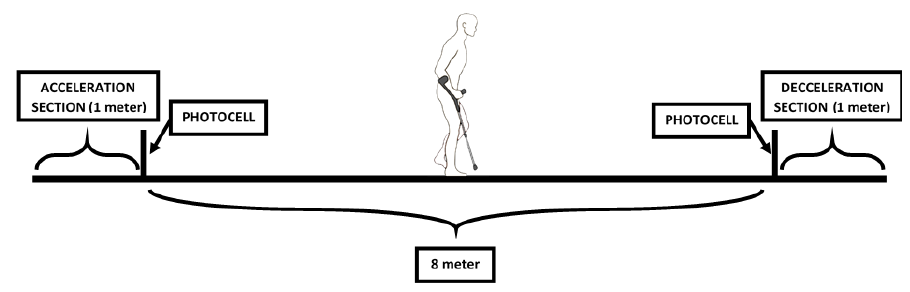
Figure 12. Ten meter walking test setup. Table 7. Selected People with Multiple Sclerosis (MS) for the exploratory